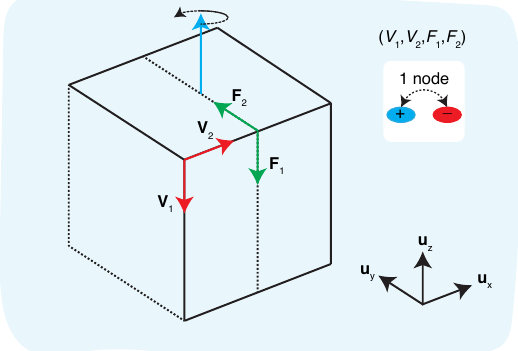
Figure 4. A sketch describing the proposed categorization scheme: vertex-edge vectors V 1 and V 2 are denoted with red, and face (hedral) vectors F 1 and F 2 with green. The blue vector indicates the axis of rotational symmetry due to the used excitation ( u z -polarized electrostatic field). A mode is characterized by four numbers, denoting the number of nodes (sign changes of the surface potential distribution) along the four vectors ( V 1 , V 2 , F 1 , F 2 ) . The combination of the four numbers and the particular symmetries of cube, allow the recreation of every mode. Please note that in the case of a sphere all V 1 , F 1 , and F 2 are parallel (or antiparallel) representing the elevation vector u θ , while V 2 becomes the azimuthal vector u φ